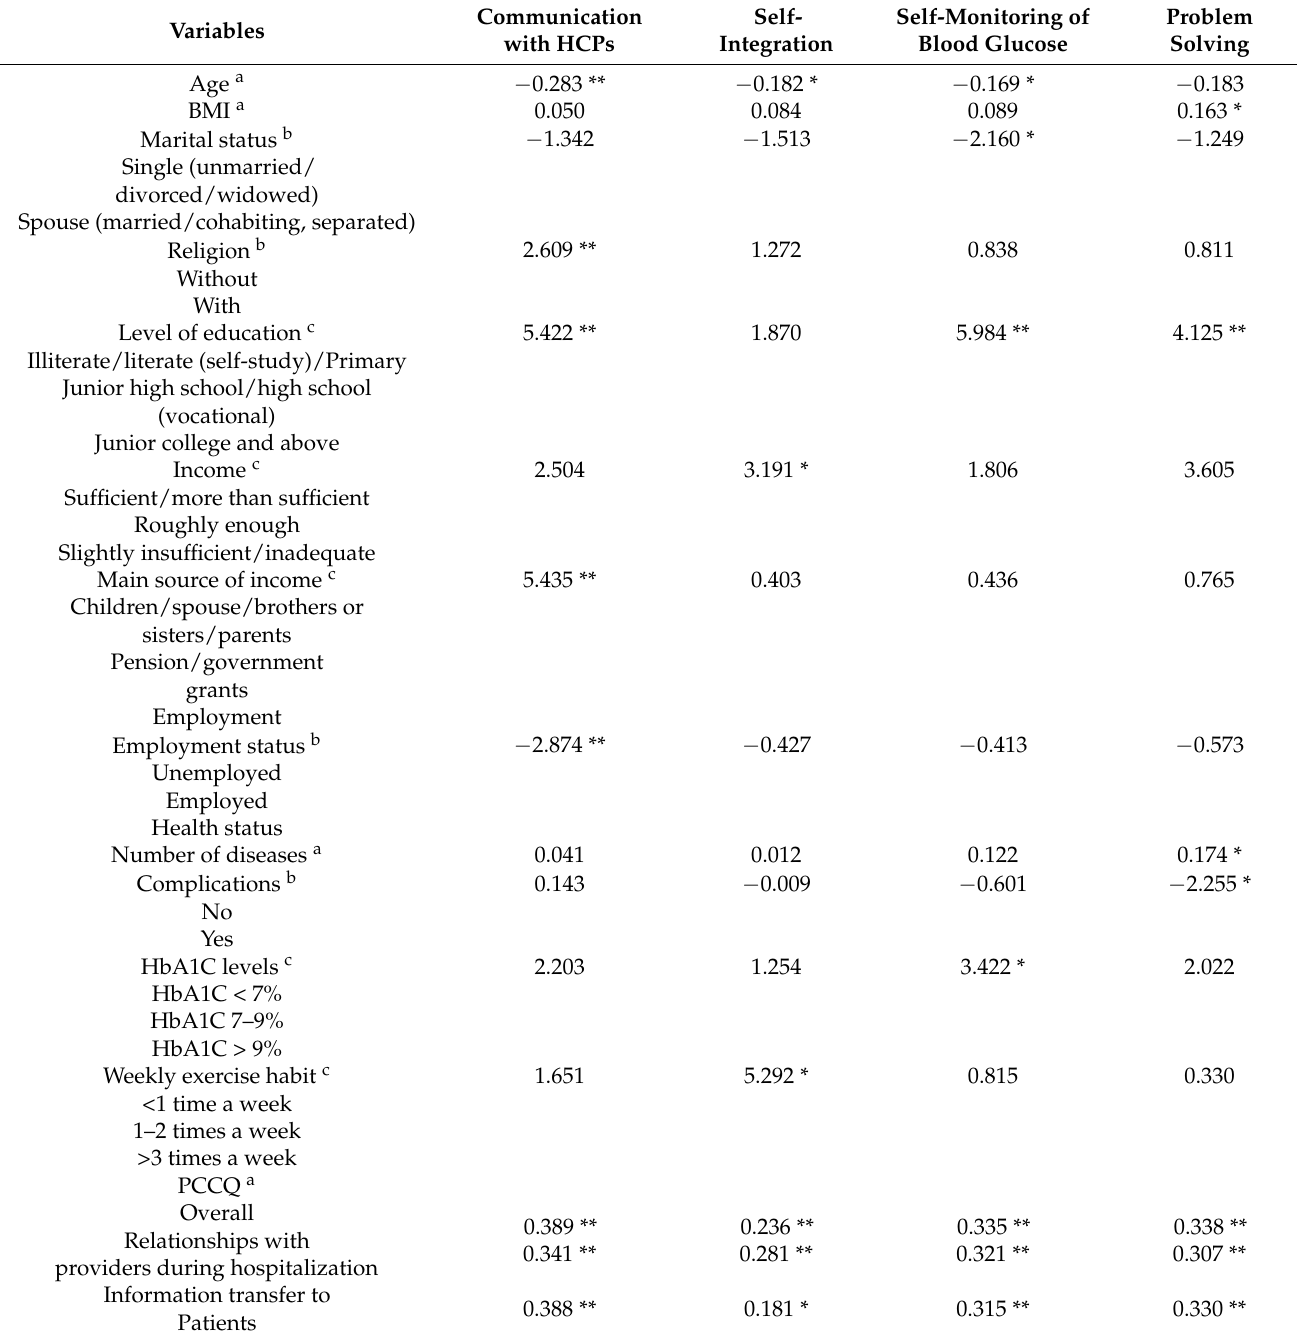
Table 3. Correlation between sociodemographic characteristics, health status, patient continuity of care, and self-management among patients with type 2 diabetes ( N =